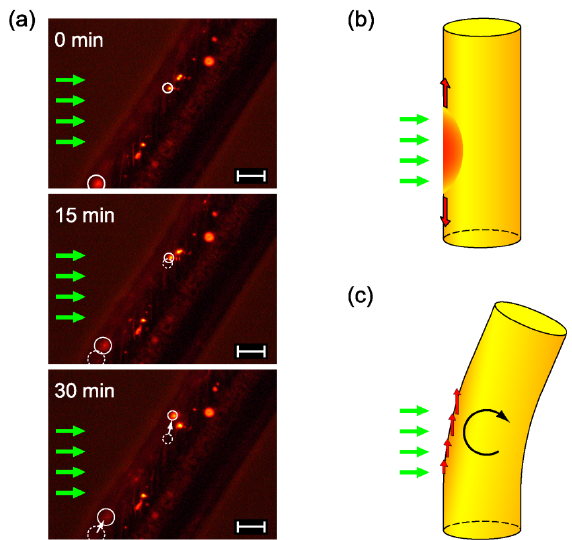
Figure 4. ( a ) Photographs of fluorescence patterns of quantum dots (QDs)-doped BFlAB fiber upon angled irradiation using H-polarized laser beam. Scale bar: 10 µm. ( b , c